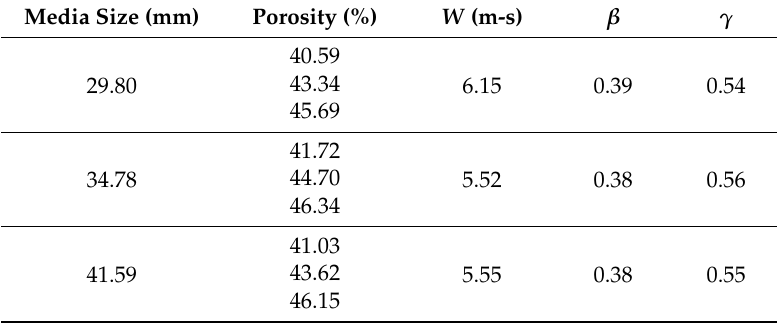
Table 2. The values of the Wilkins coefficient with variation in media size.